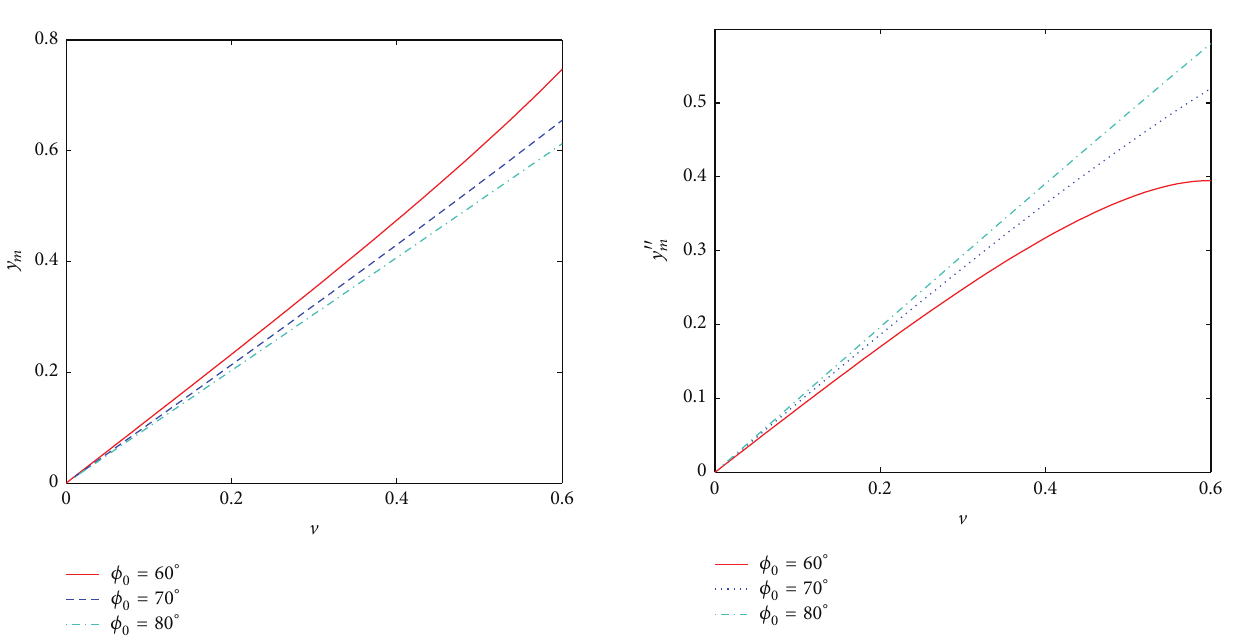
Figure 5: Maximum response nondimensional acceleration of the system when the suspension angle 𝜙 0 = 60 ∘ , 70 ∘ , 80 ∘